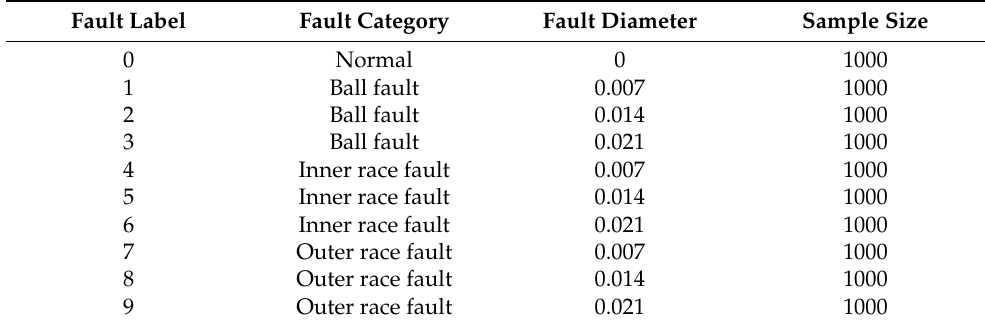
Table 1. The experimental dataset of CWRU.